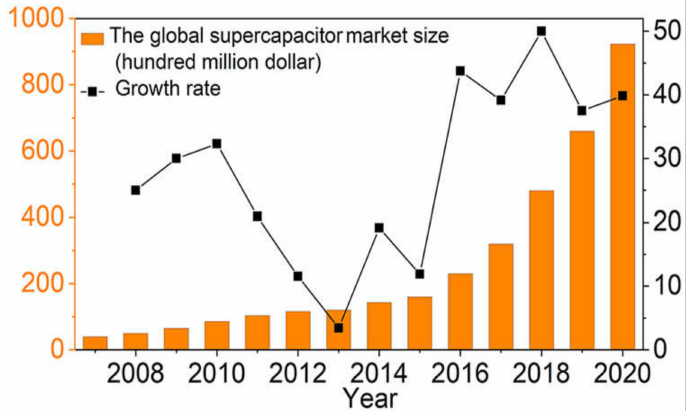
Figure 3. The size of the global supercapacitor market and its growth rate. Reproduced with permission from [36]. AIP Publishing LLC,